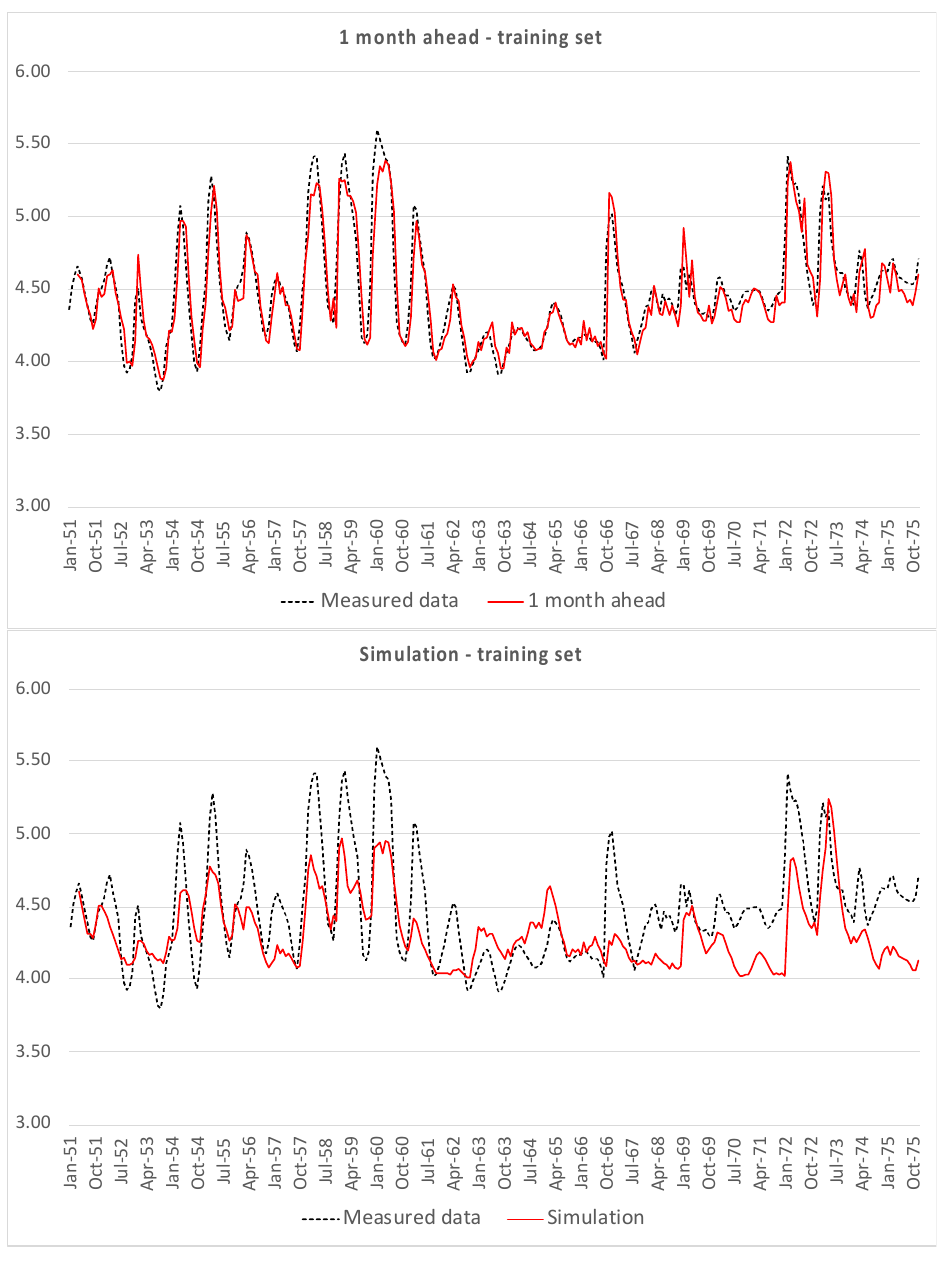
Figure 8. One month ahead prediction and simulations of NNARX returned models for the training set, i.e., Casello 49, piezometric levels on the vertical axis are in m a.s.l.